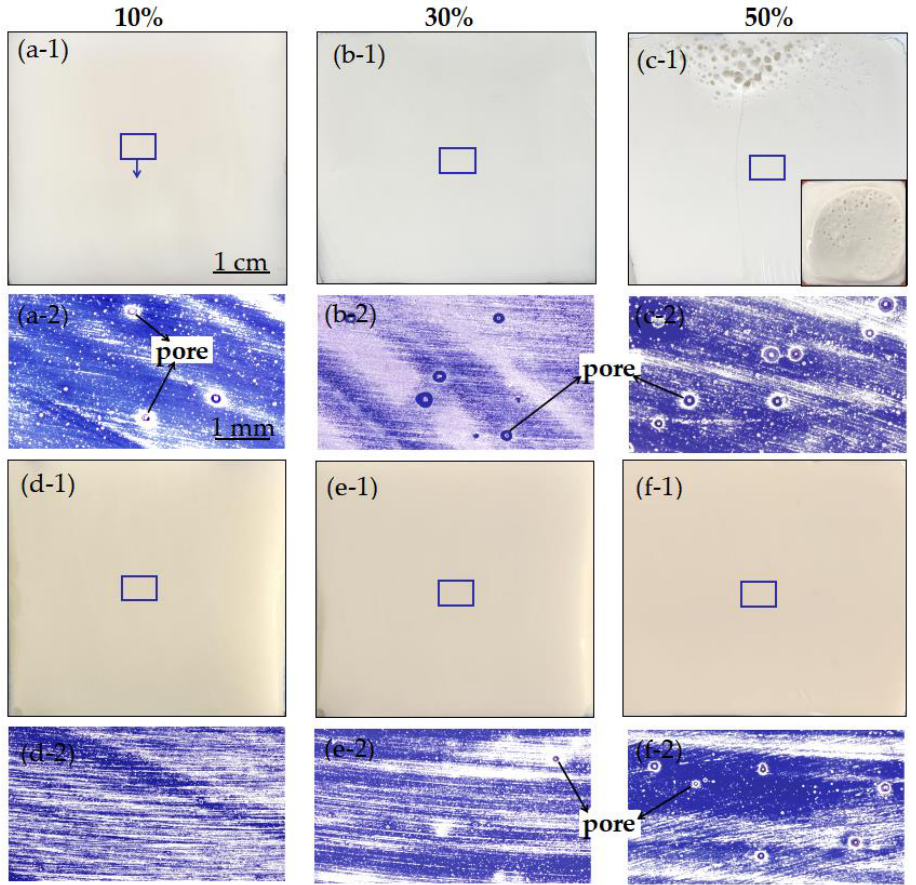
Figure 9. Cross-sectional view of the cured UPR composites under microwave curing ( a-1 – c-2 ) and thermal curing ( d-1 – f-2 ).